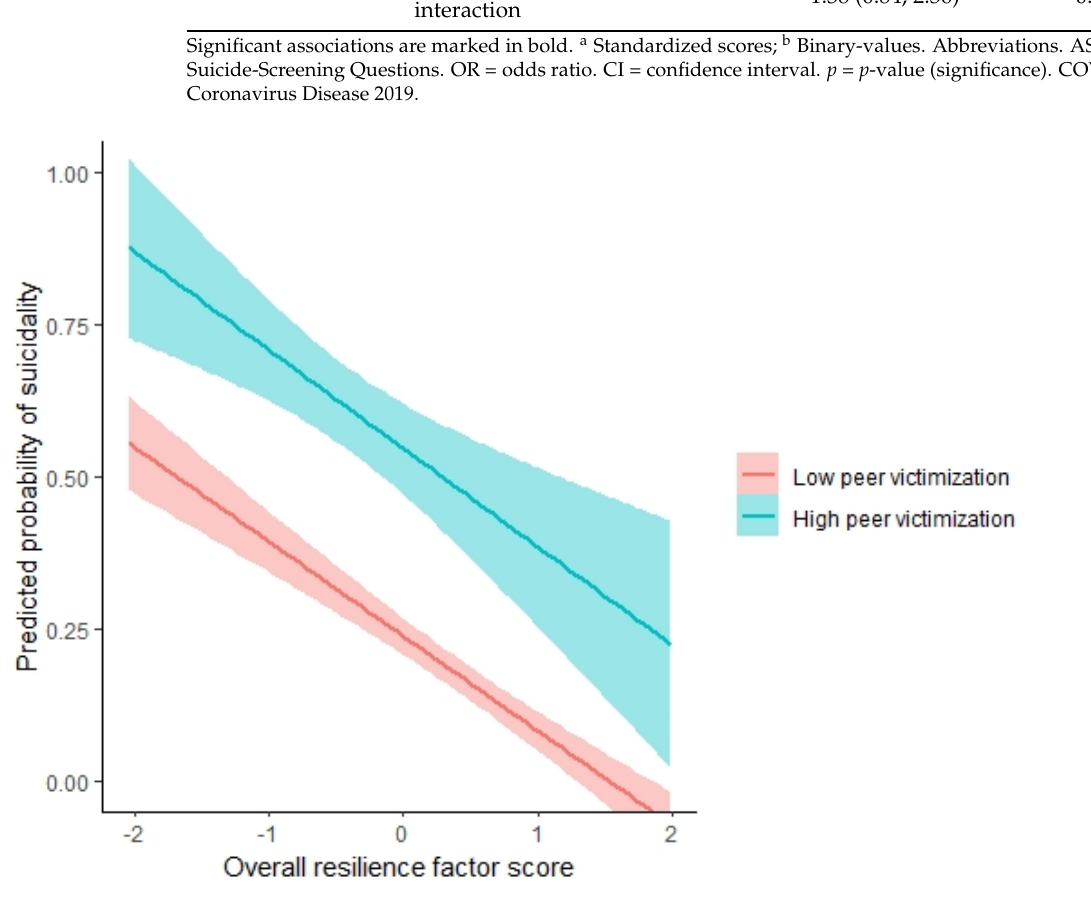
Figure 1. Association among overall resilience factors score (X axis, standardized scores) and pre- dicted chances of suicidality (Y axis, odds of predicted suicidality [operationalized as ASQ score ≥ 1] range between 0-1 with 95% confidence interval). Low peer victimization (red) group = youth in the bottom tertial (0–33%) of peer victimization scores. High peer victimization (blue) group = youth in the top tertial (66.7–100%) of peer victimization scores. Greater overall resilience factors score is associated with lower odds of suicidality independently of peer victimization levels.